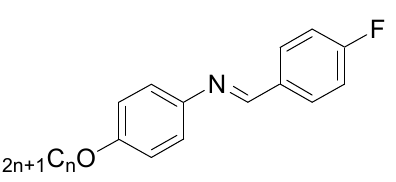
Figure 4. N -4-fluorobenzylidene-4-(alkyloxy)benzenamine, II n .